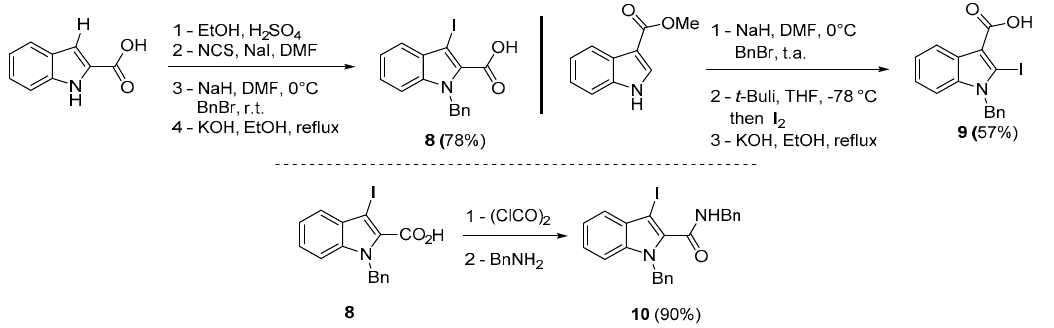
Table 1. Synthesis of 1 , 2 , 3, 4, 5 and 6 via tandem Stille coupling/heterocyclization reaction.